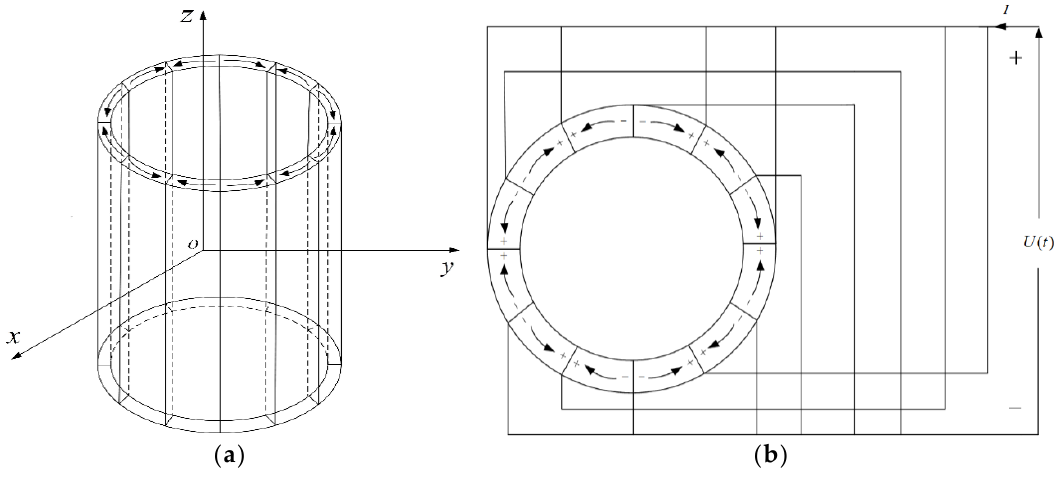
d 33 are the piezoelectric constants of piezoelectric materials; ε T piezoelectric materials that are under constant stress.